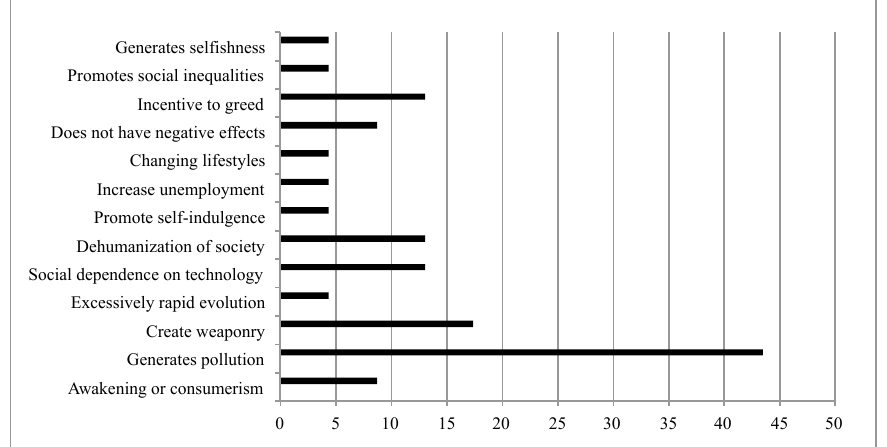
Fig. 3. In the students' opinion, what is the worst impact/influence that engineering has on society (% of total